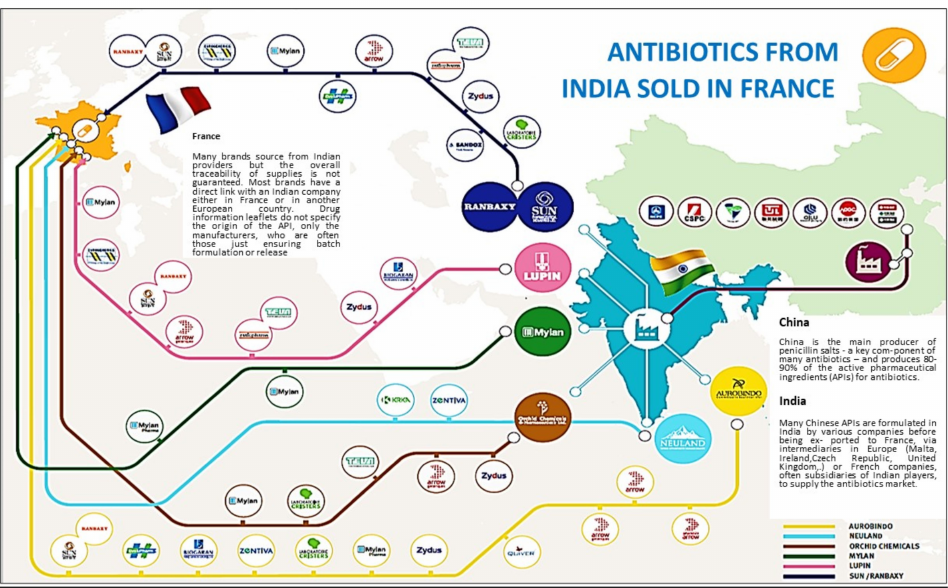
Figure 2. The complex circuits of antibiotic production. Reproduced and translated with permission from https://changingmarkets.org/portfolio/bad-medicine/ accessed on 16 May 2022